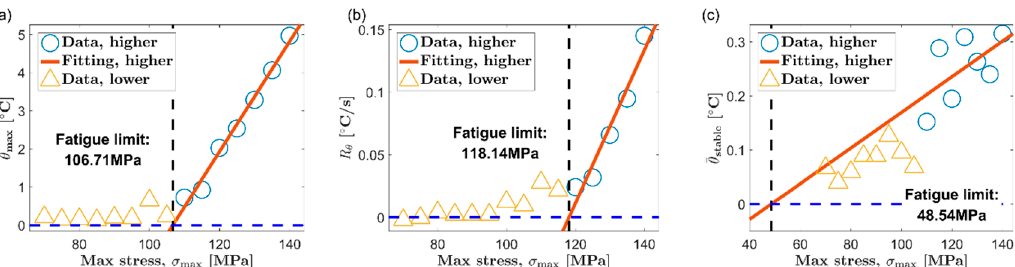
𝜃̿ (cid:2929)(cid:2930)(cid:2911)(cid:2912)(cid:2922)(cid:2915) . 𝜃̿ = (cid:2929)(cid:2930)(cid:2911)(cid:2912)(cid:2922)(cid:2915) . θ 𝜃̿ stable . (cid:2929)(cid:2930)(cid:2911)(cid:2912)(cid:2922)(cid:2915) .